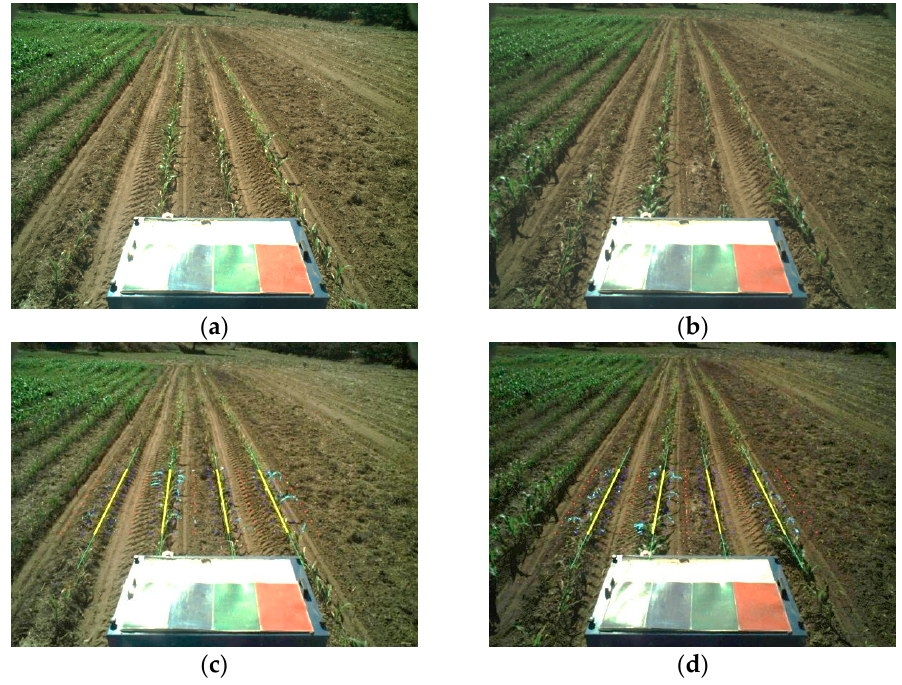
Figure 16. Alignment of the vehicle along the crop rows. Images adapted and taken from [47]: ( a ) original image with deviation; ( b ) original image after correction; ( c ) misalignment of the tractor with respect the crop rows; ( d ) misalignment corrected.